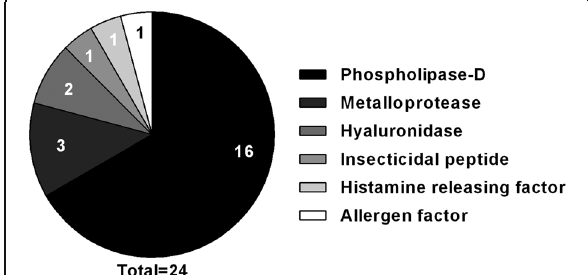
Fig. 3 Loxosceles recombinant toxins. Graph shows the percentage of recombinant Loxosceles toxins described in the literature classified by class of toxins. In each type of toxin, the number of recombinant isoforms is